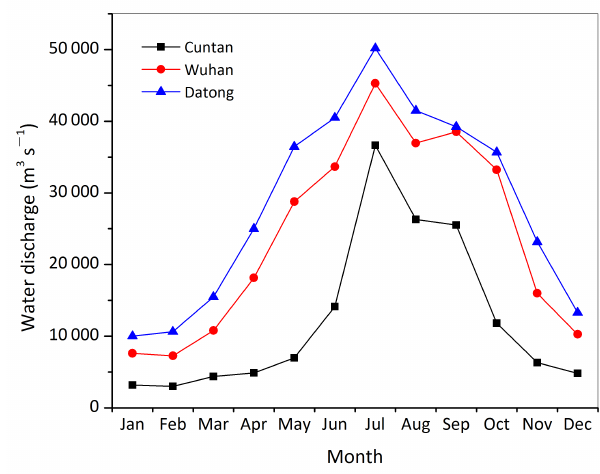
Figure 2. Monthly variations in water discharge of the Yangtze River at Cuntan (upper reach), Wuhan (middle reach), and Datong stations (lower